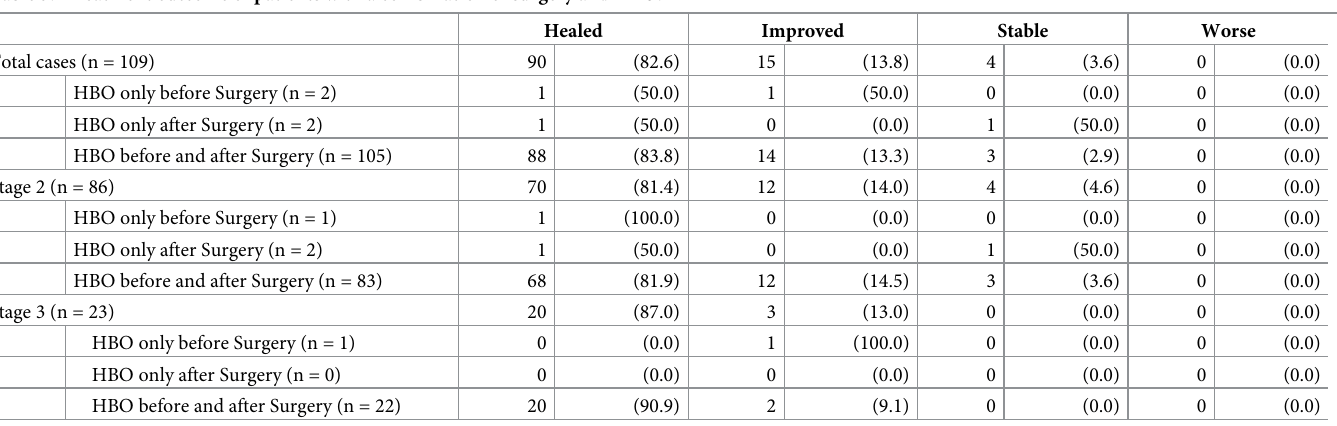
Table 3. Treatment outcome of patients with a combination of surgery and